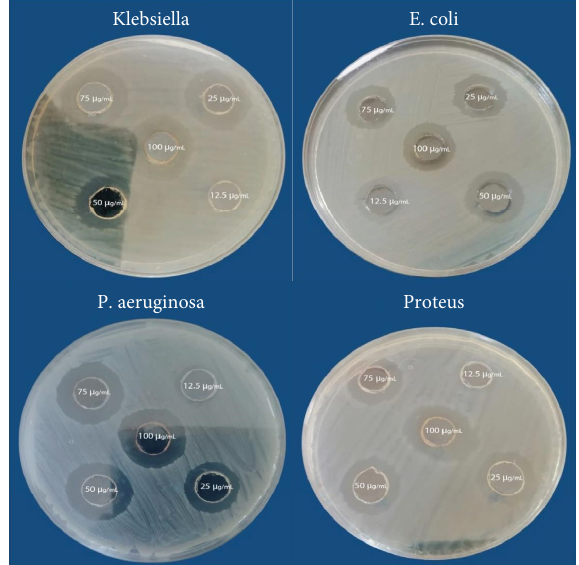
Figure 5: Bacterial growth inhibition zone achieved in the agar well difusion method by the concentration of AgNPs at 12.5, 25, 50, 75, and 100 µ g · mL − 1